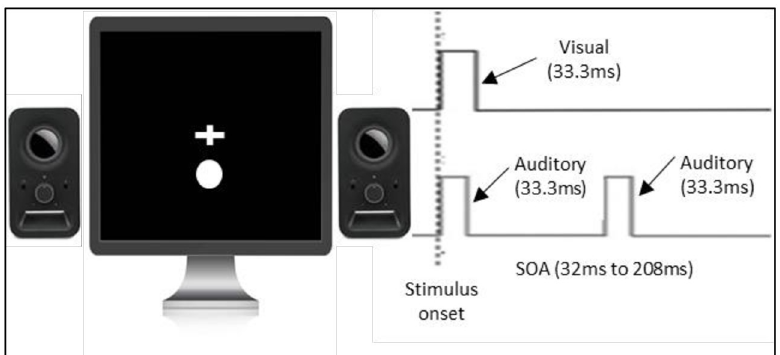
Fig 4. Paradigm of the double-flash illusion